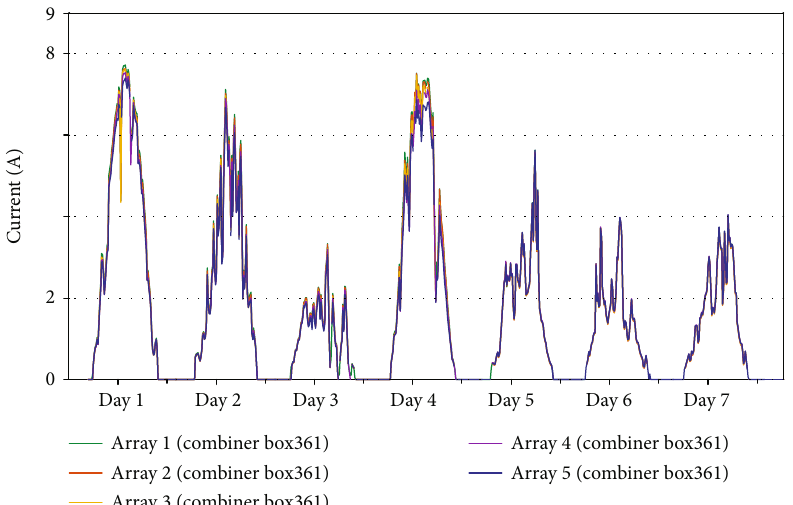
Figure 1: Current distribution of di ff erent arrays.